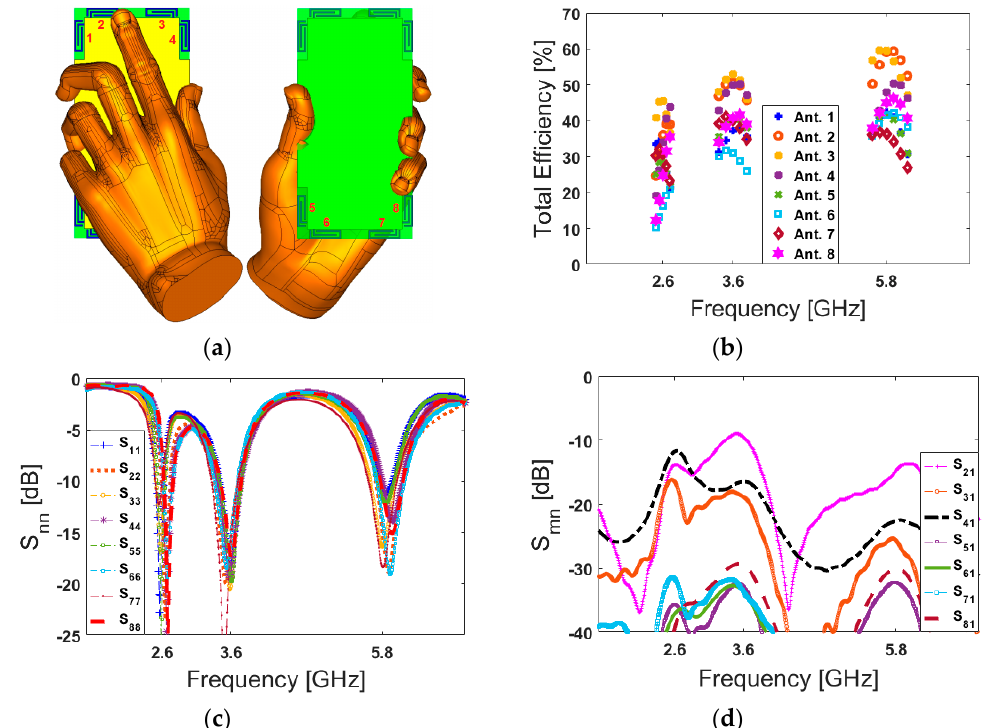
Figure 15. ( a ) Placement, ( b ) total efficiencies, ( c ) S nn , and ( d ) S mn results for the left-hand scenario.